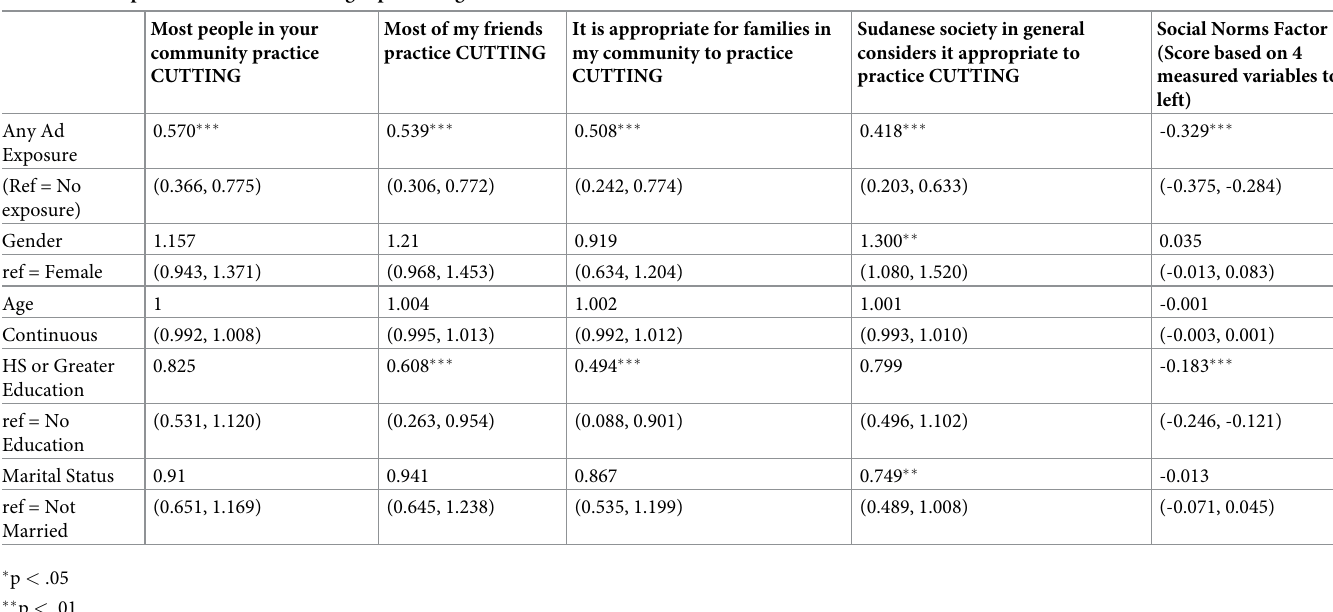
Table 3. Self-reported Saleema advertising exposure regressions at wave 3.